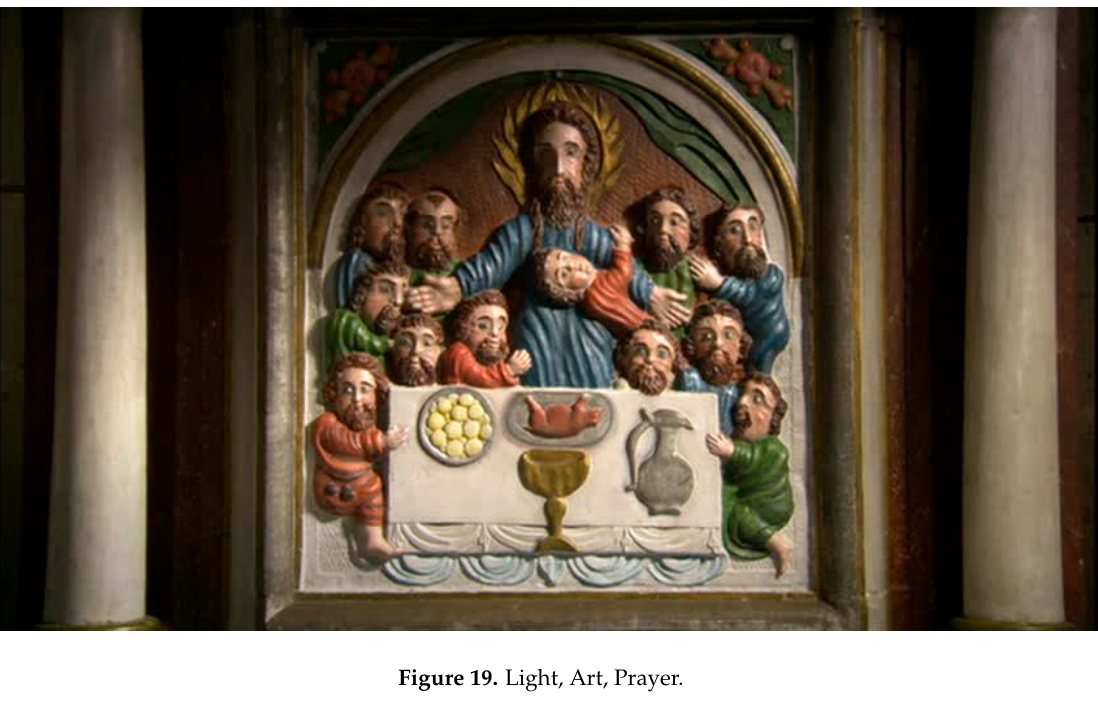
Figure 19. Light, Art, Prayer.